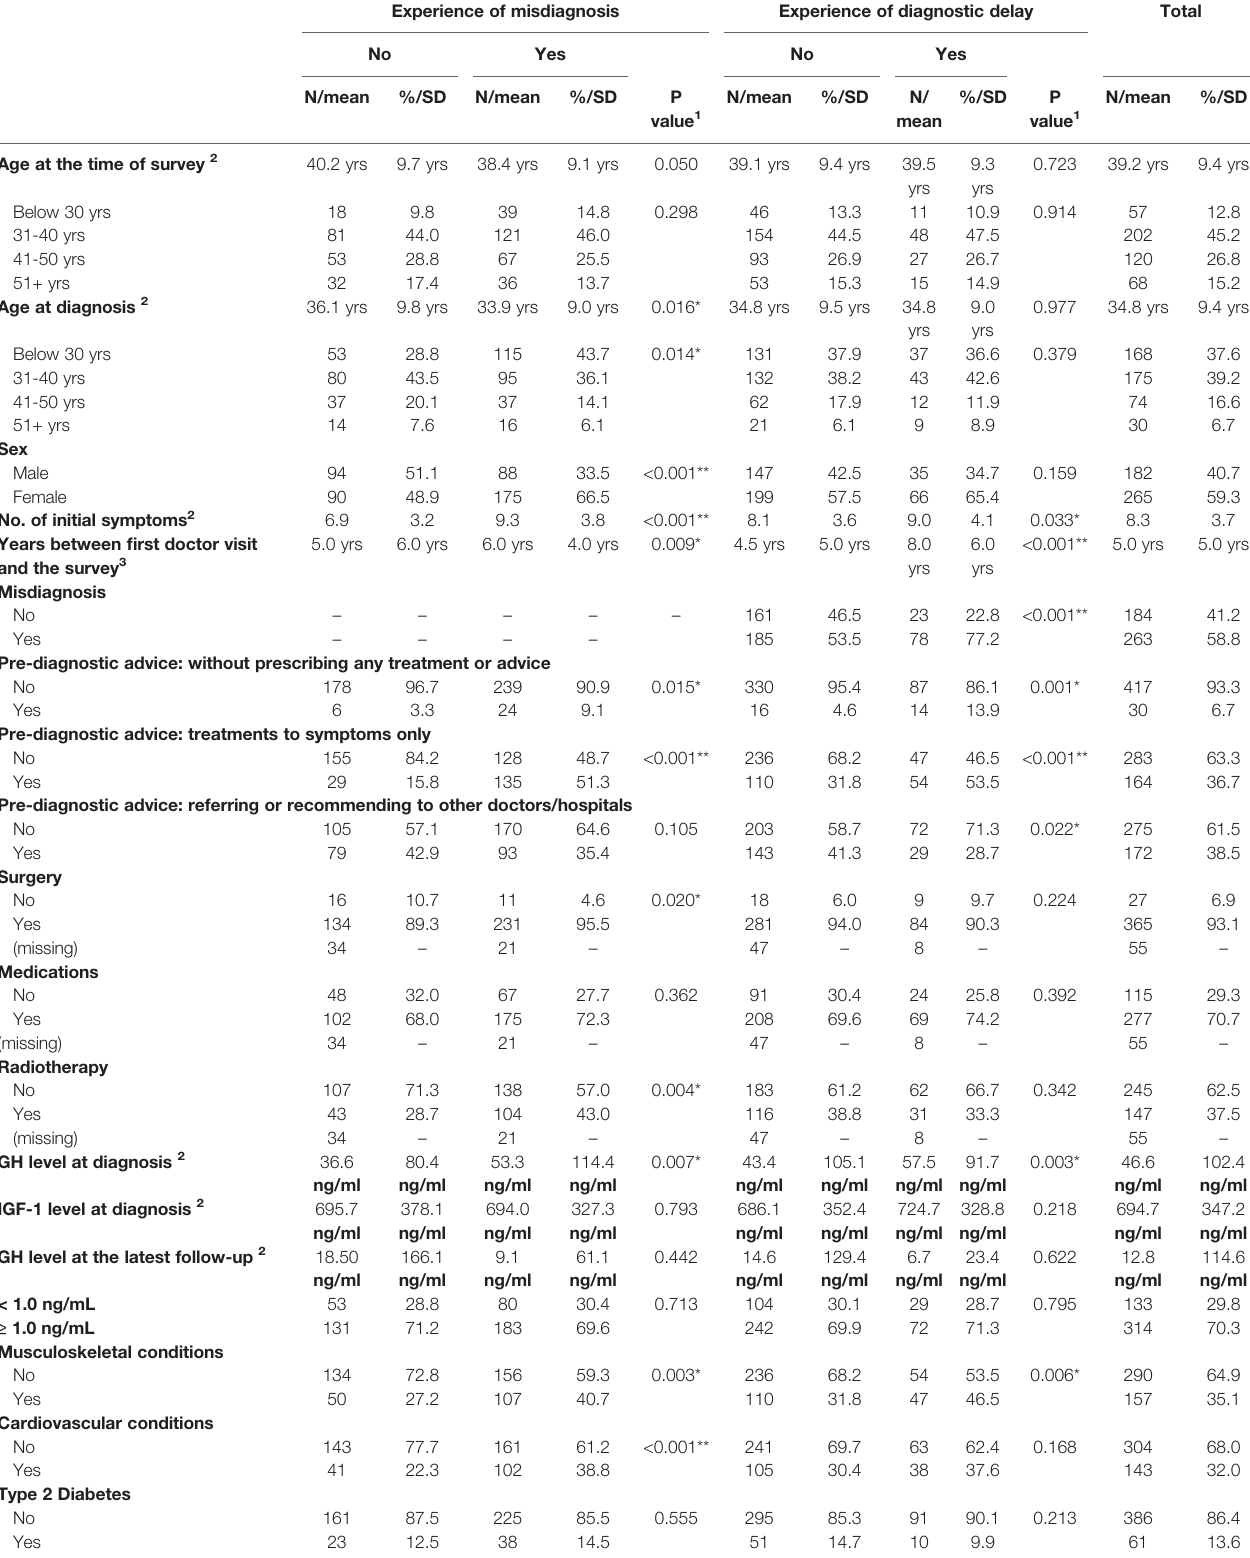
TABLE 1 | Demographical and clinical characteristics of participants with or without experience of misdiagnosis and diagnostic delay. Experience of misdiagnosis Experience of diagnostic delay